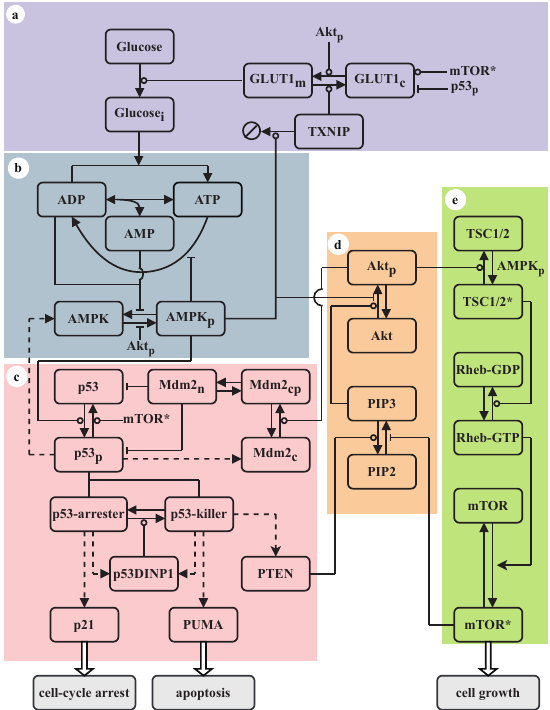
Figure 1. 1 Figure 1. Schematic of the model. The model consists of five modules: glucose uptake ( a ), the AMPK ( b ), p53 ( c ), PI3K/Akt ( d ), and TSC/mTOR ( e ) pathways. State transition is represented